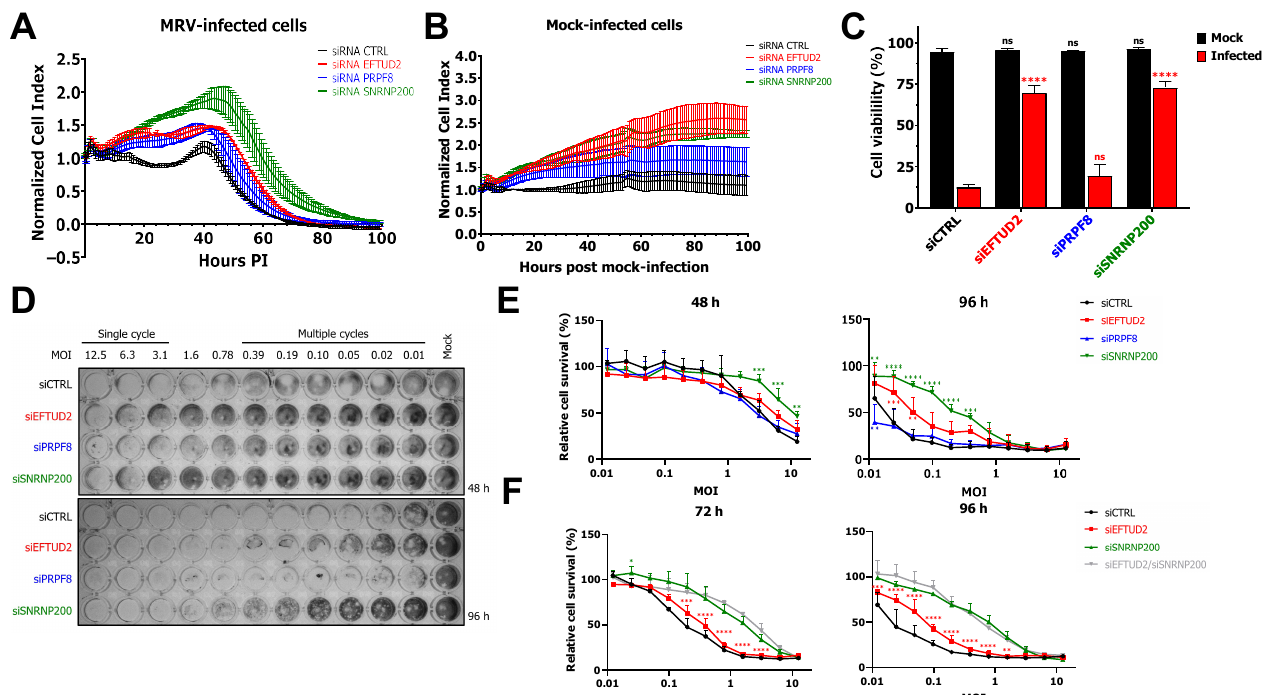
Figure 1. EFTUD2 and SNRNP200 KD protect cells from death after MRV infection. ( A ) RTCA of MRV-infected L929 cells (MOI of 3) transfected with a control siRNA or EFTUD2, PRPF8, or SNRNP200 specific siRNA. Measurements were made every 10 min. n = 3, biological replicates. ( B ) RTCA of mock-infected L929 cells transfected with a control siRNA or EFTUD2, PRPF8, or SNRNP200 specific siRNA. Measurements were made every 10 min. n = 3, biological